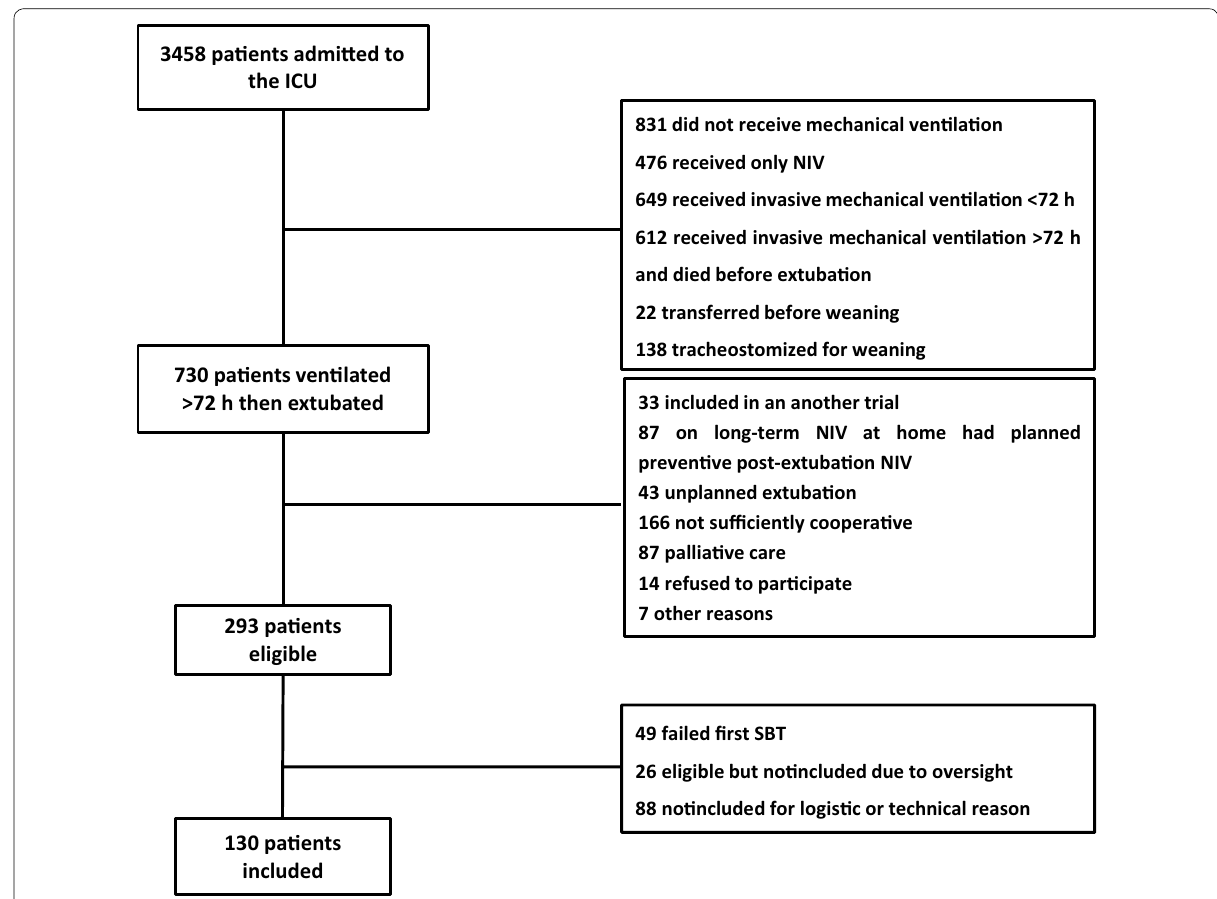
Fig. 1 Flowchart of the